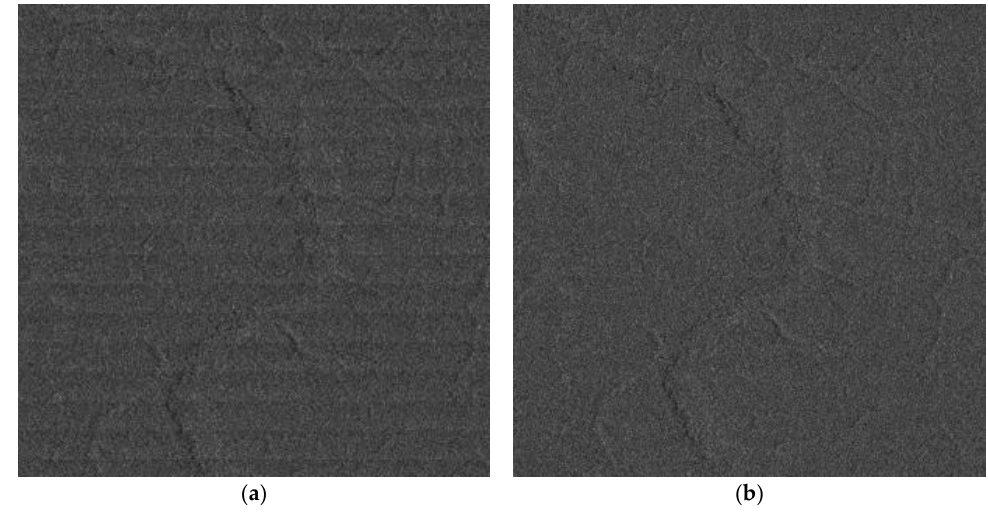
Figure 13. The GF-3 narrow scanSAR imagery ( a ) before de-scalloping and ( b ) after de-scalloping of rainforest of Brazil (acquired at 25 February 2017).